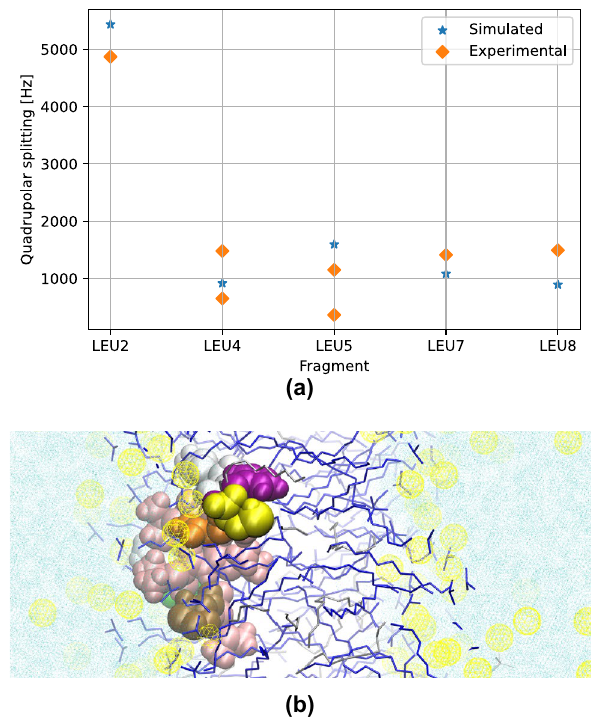
2 H-NMR quadrupolar splittings ( �ν ) of its